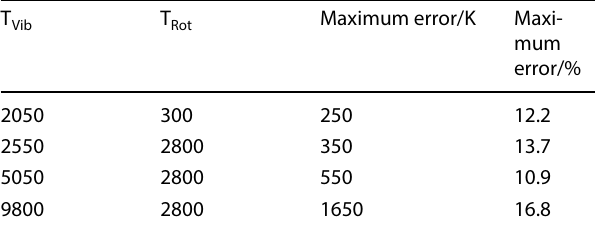
Table 1 Calculated maximum absolute and percentage error at dif- ferent vibrational (T ) and rotational temperatures (T Vib